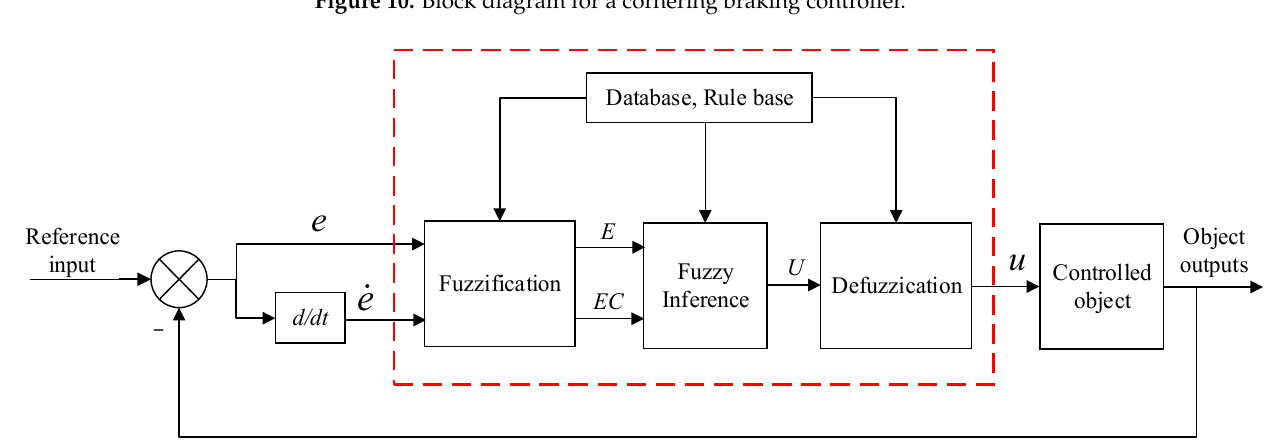
Figure 10. Block diagram for a cornering braking controller.